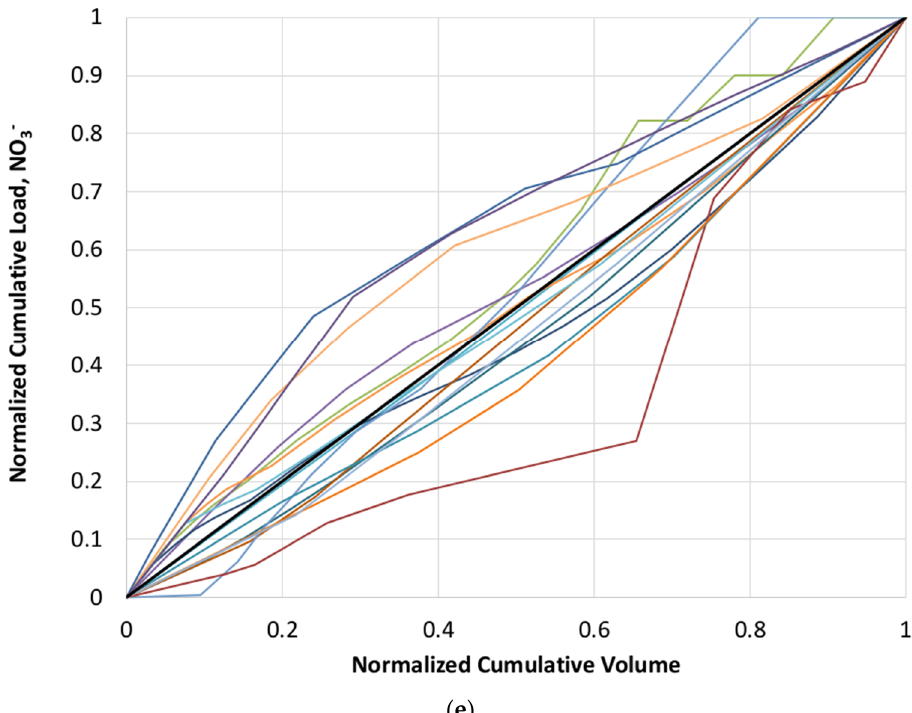
Figure 2. Traditional first flush normalized cumulative pollutant load vs. cumulative volume curves for Second Creek. ( a ) Fecal coliform, ( b ) E. coli , ( c ) TSS, ( d ) Cu 2+ , and ( e ) NO 3− .